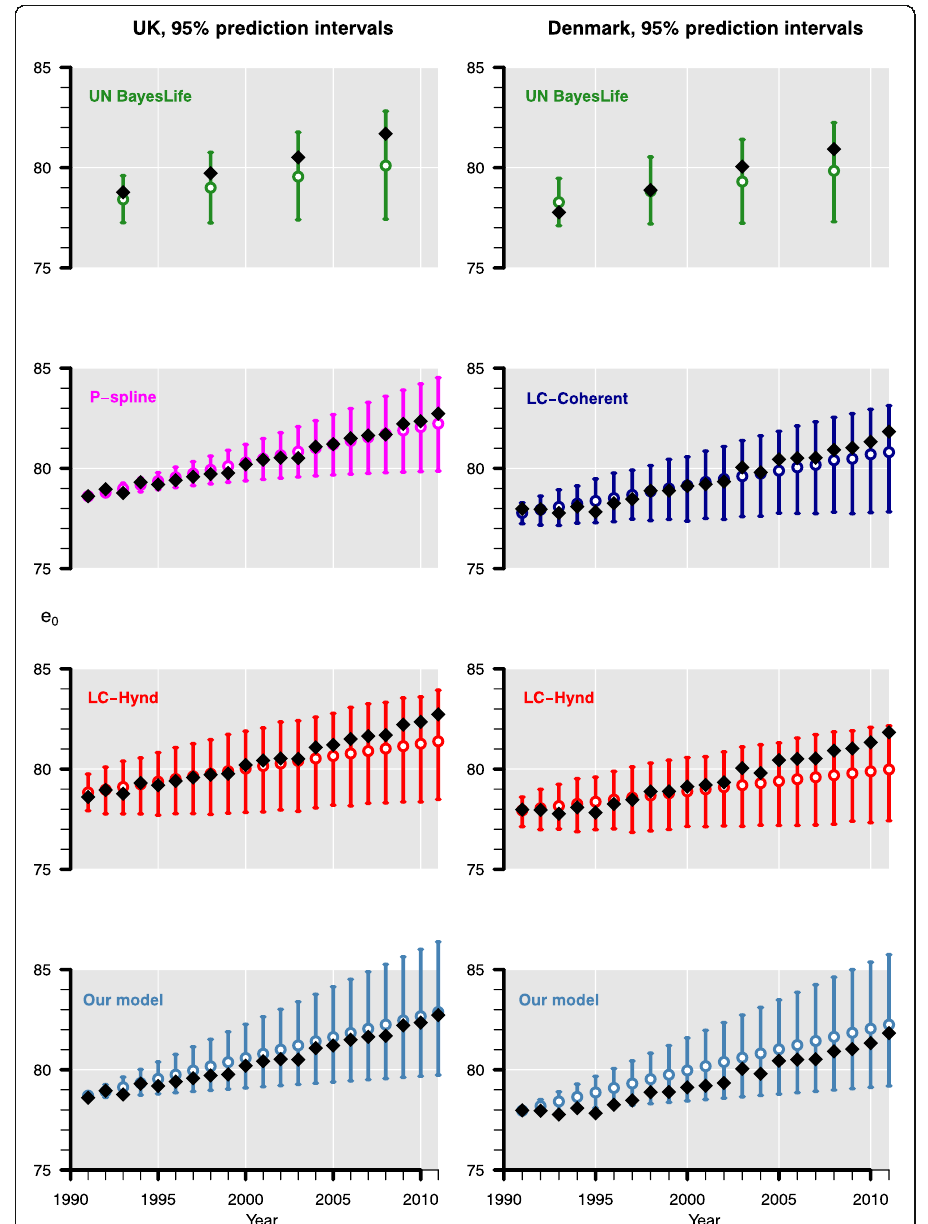
Fig. 13 Validating forecasts from 1991 to 2011, given data from 1965 to 1990, of our model ( blue ), the LC model ( red ), its coherent variant ( dark blue ), the P-spline method ( magenta ), and of the UN Bayesian approach ( green ) for British ( left ) and Danish ( right ) women. Observed life expectancy ( e 0 ) is represented by black squares , the median forecasts by white circles , and the 95% prediction intervals by the vertical lines . We combine the mortality trends of Danish and Swedish women in our model as well as in the coherent LC